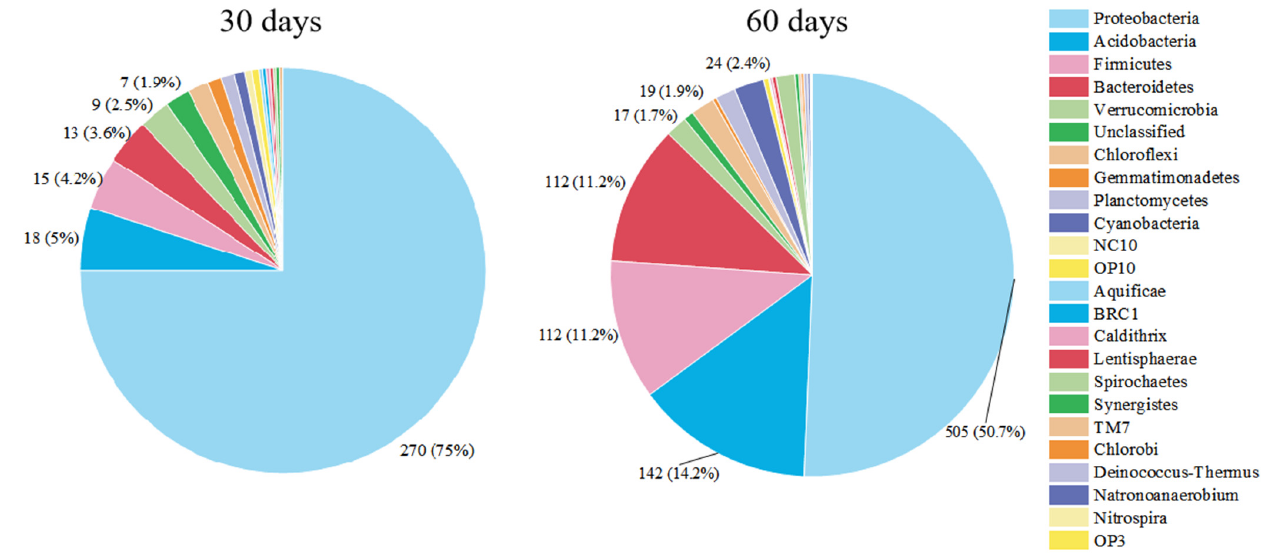
Figure 3. Relative abundance of bacteria (Phylum level) in MBfRs with an operation time of 30 days and 60 days.